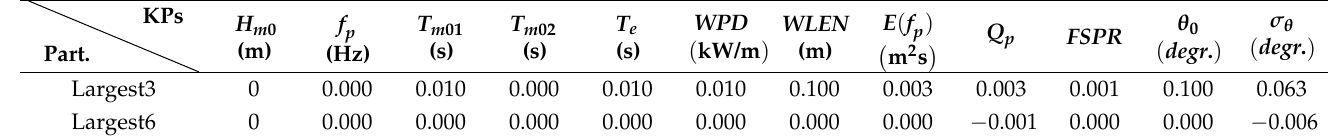
Table 8. Mean absolute error (MAE) of the KPs derived from the original and the reconstructed spectra (with the three and six largest partitions) at check point B2. The values of MAE are expressed as the differences to those obtained from the original spectra and the reconstructed ones using the four largest